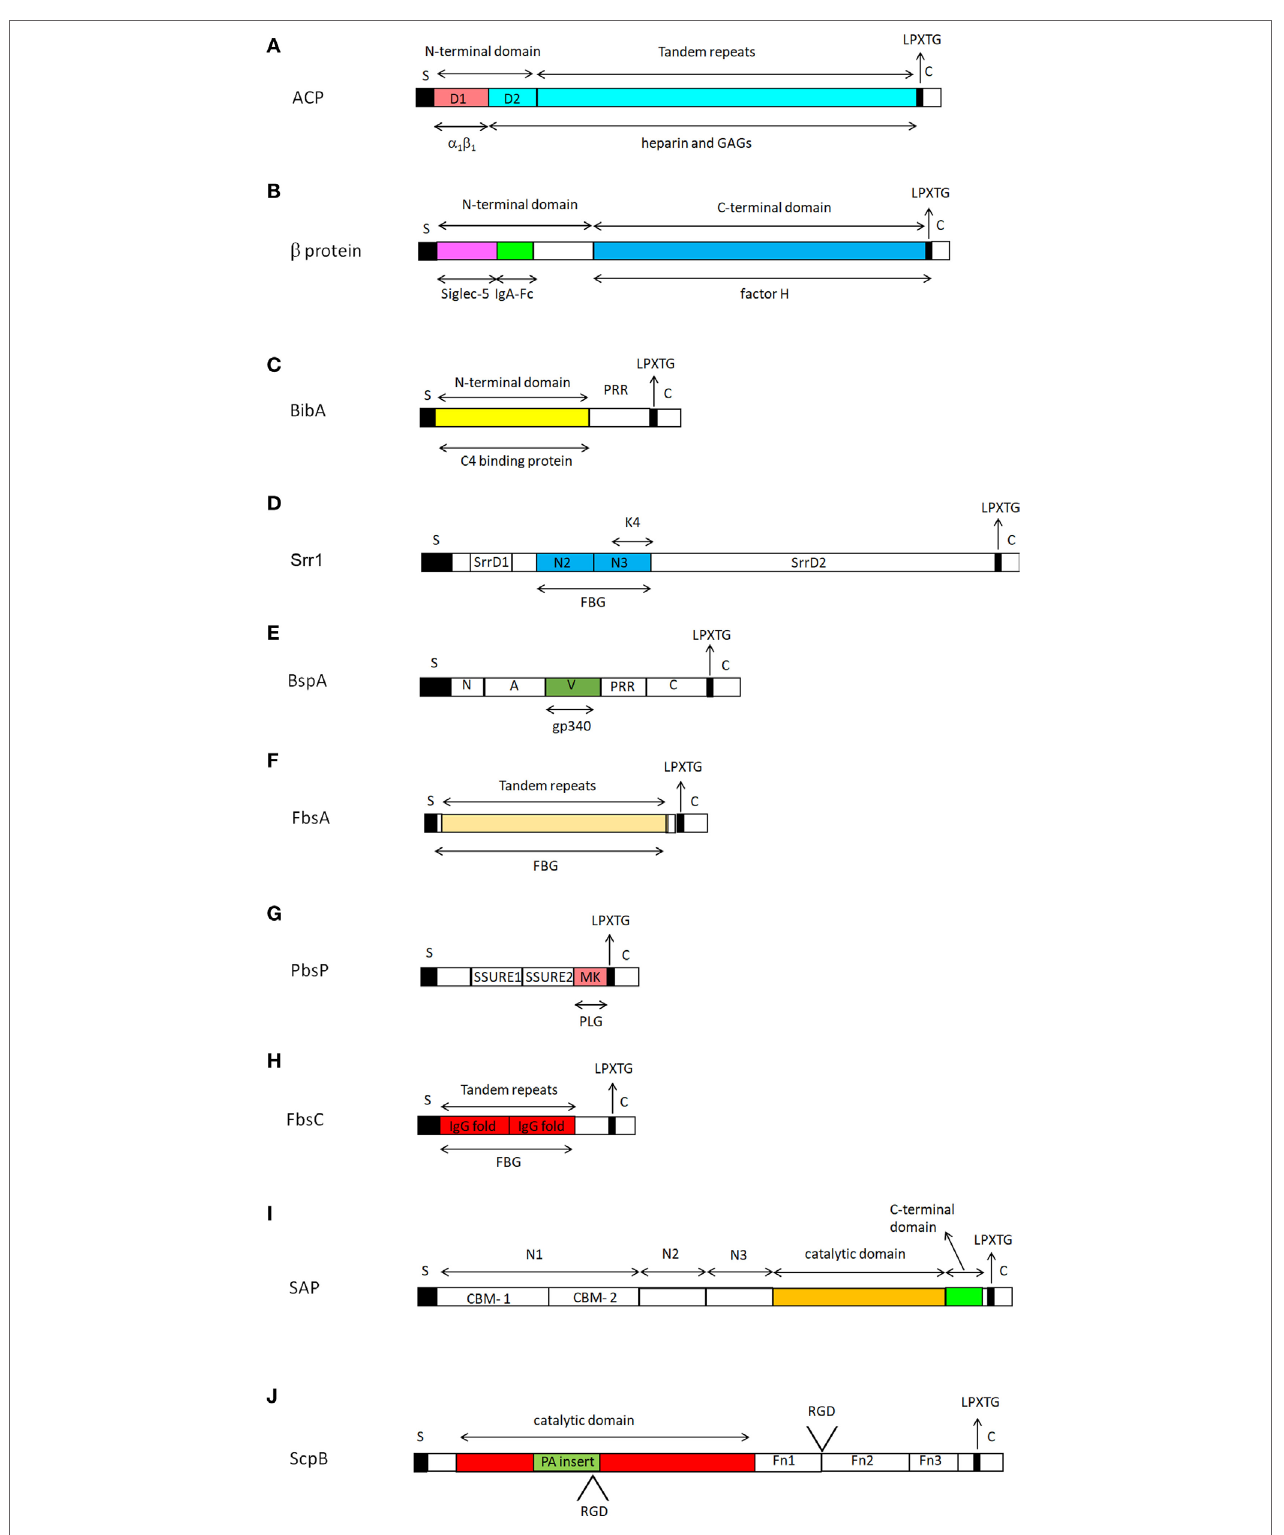
FiGURe 3 | Representation of the structure of cell wall-anchored proteins from Streptococcus agalactiae . All cell wall-anchored S. agalactiae proteins contain a signal sequence (S) at the N-terminal end and a sorting signal (LPXTG) at the C-terminus. The signal sequences are removed during secretion across the cytoplasmic membrane. Each CWA protein is identified with a capital alphabetic letter (A–J) . Domains involved in specific ligand binding are also shown. For further details see the text. Drawings of CWA protein here reported are those for which the domain organization and ligand binding sites have been defined.